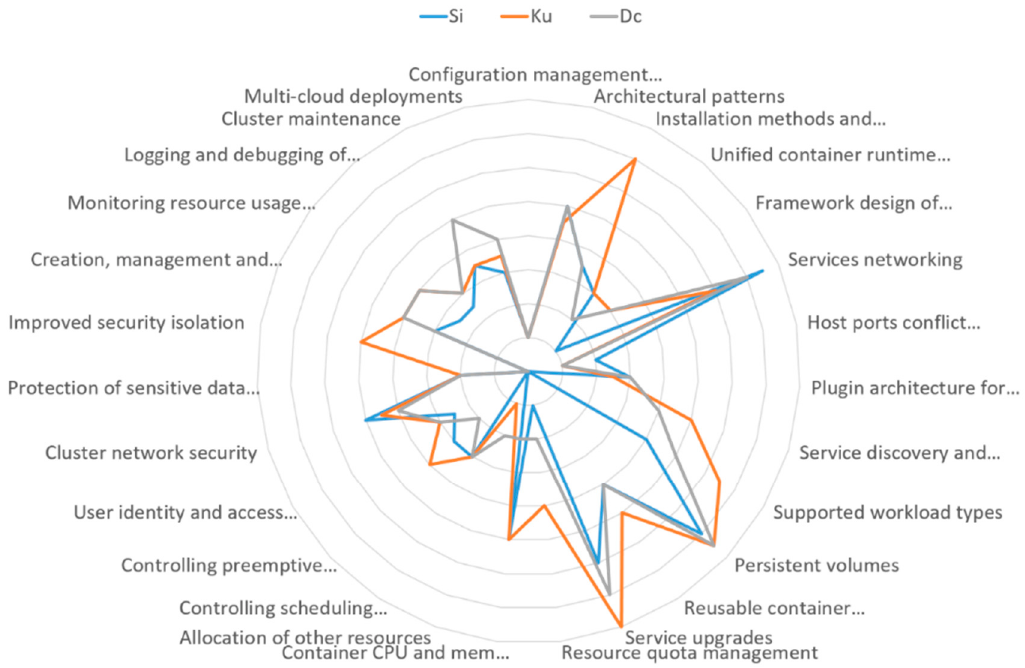
Figure 8. Radar chart of Docker Swarm integrated mode, Kubernetes and DC/OS to graphically present in which sub-aspects these CO frameworks support the highest number of common features. RQ6b. Which functional sub-aspects are best supported by a CO framework in terms of common features ánd